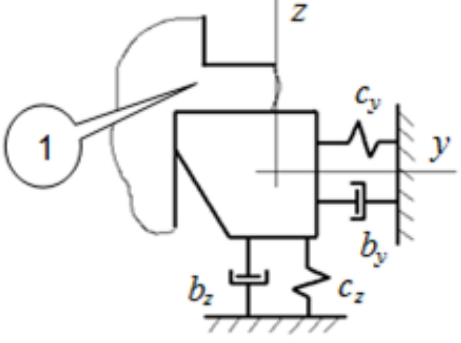
Figure 1. Double-loop dynamic model of the technological system